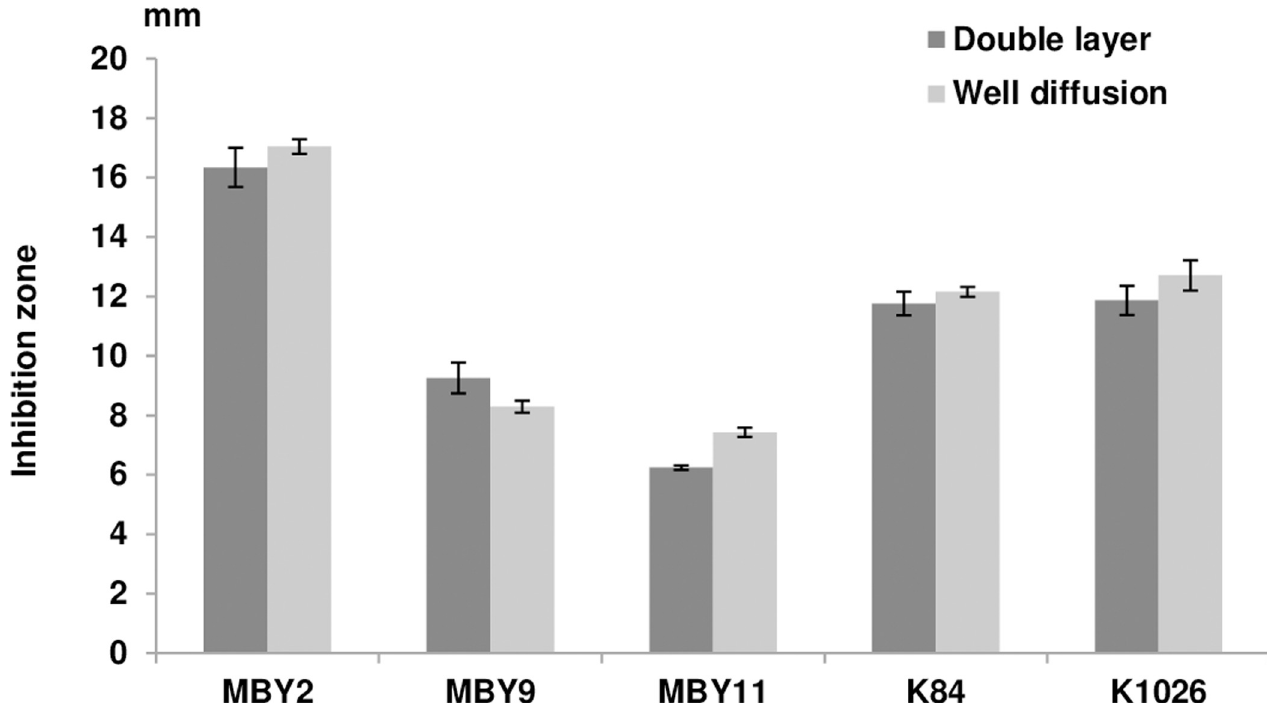
Fig 1. Inhibition of growth of A . fabrum C58 by bacterial antagonists in vitro . Diameters (in mm) of the inhibition zones caused in plates carrying A . fabrum C58 by the Tunisian Bacillus isolates MBY2, MBY9, and MBY11 as well as the commercial biocontrol strains A . radiobacter K84 and K1026 were determined by both the double layer and the well diffusion method after 48 h at 25˚C. Error bars display the standard deviation of three biological replicates performed for each